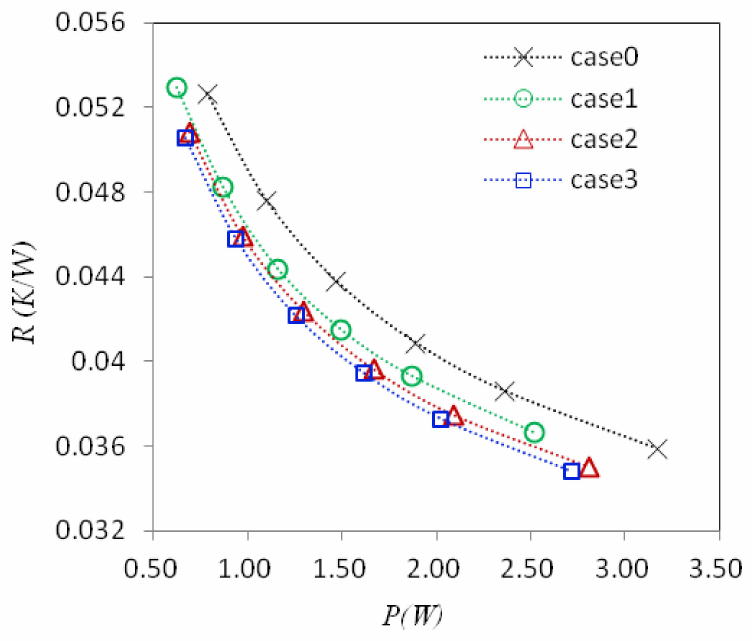
Figure 6. Total thermal resistance vs. pumping power of the four microchannel